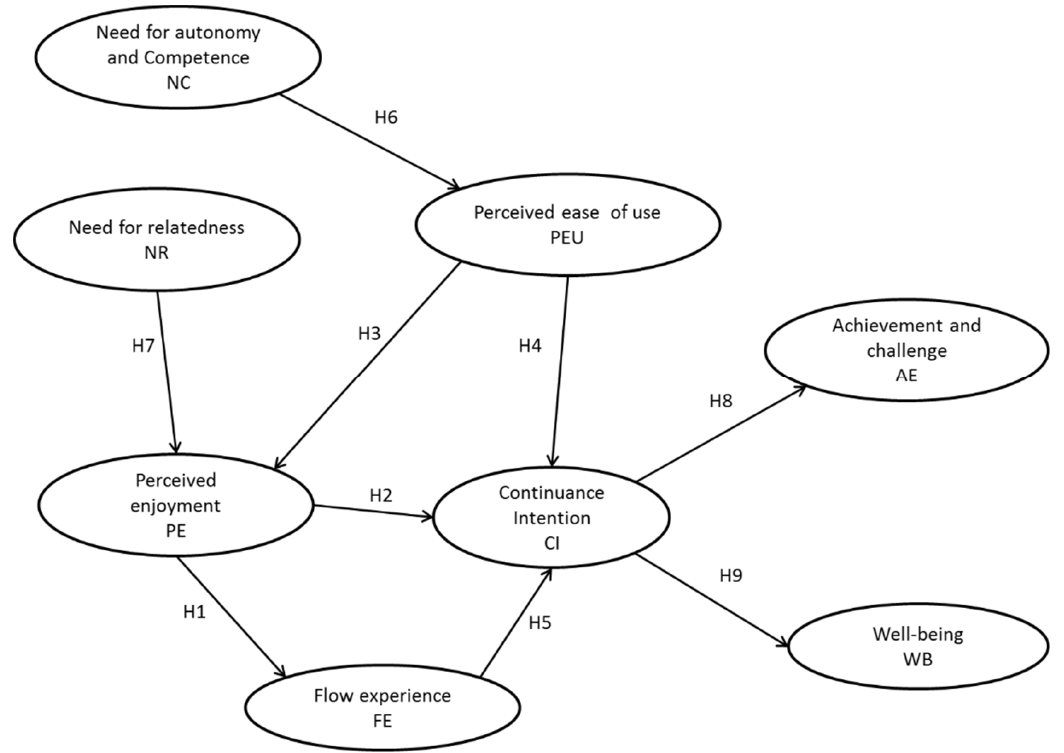
Figure 1. Proposed model. Sources: [19,21,37].